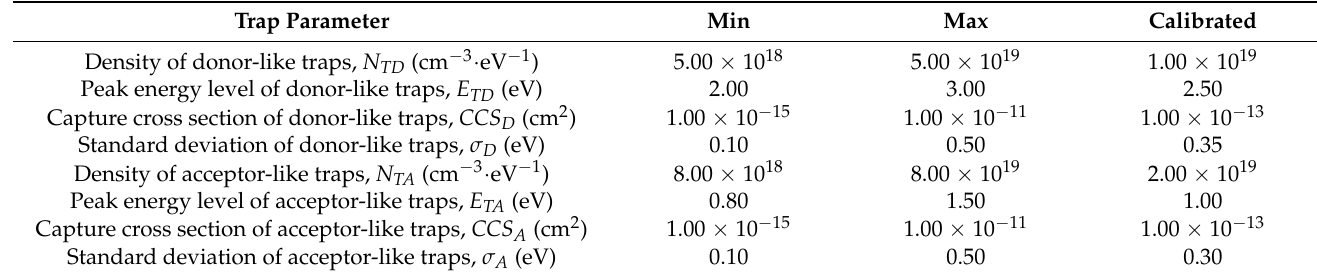
Figure 4. Scheme of eight inputs (Table 1) for two outputs (| V th , ers | and V th , pgm ) in ANN. An MLP was used as a learning algorithm to train the ANN. In the backward direction, the eight inputs can be found in the direction of making the two outputs large. Table 1. Input parameters of energetic-trap distributions of the CTN.